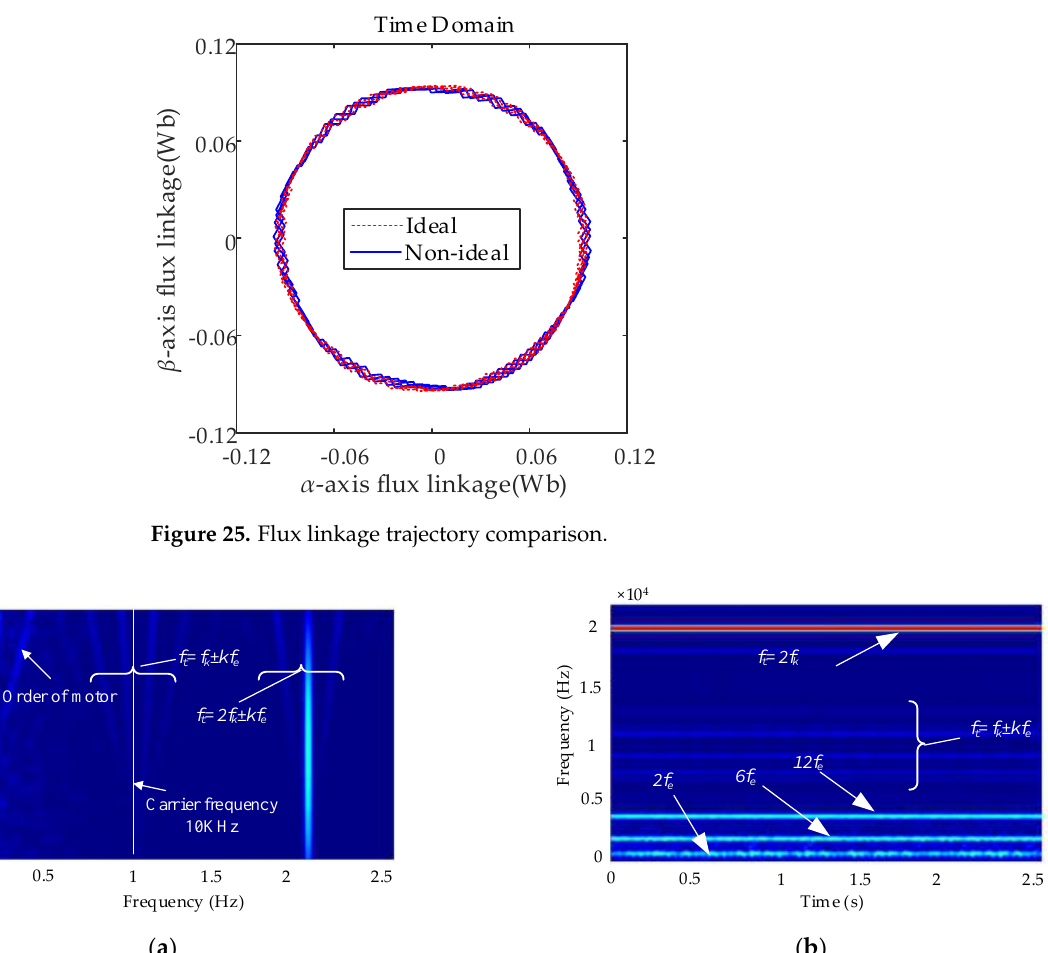
Figure 25. Flux linkage trajectory comparison.